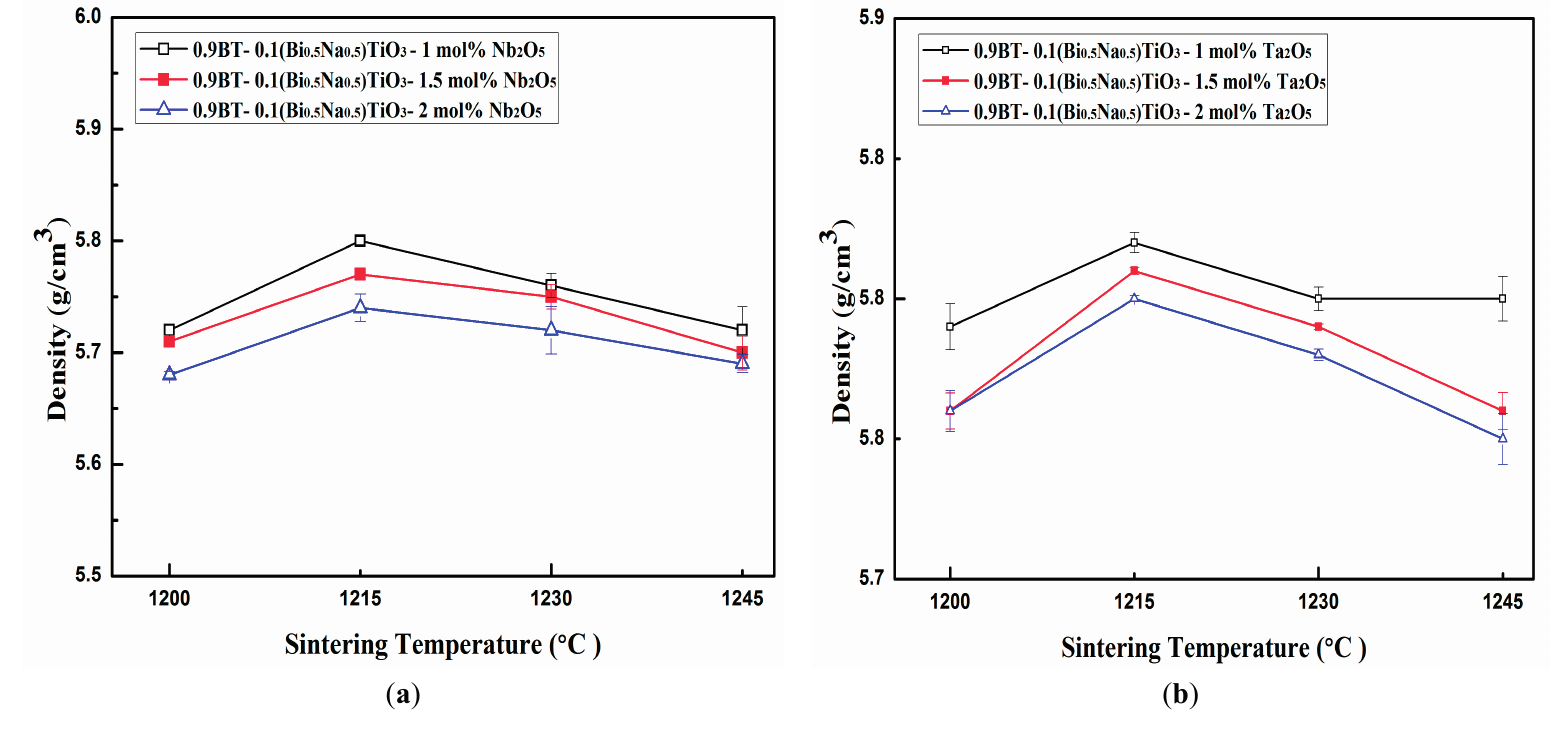
Figure 1. Apparent densities of 0.9BaTiO 3 –0.1(Bi 0.5 Na 0.5 )TiO 3 ceramics with various amounts of ( a ) Ta 2 O 5 and ( b ) Nb 2 O 5 sintered at different temperatures for 2